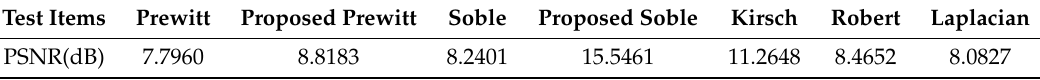
Table 2. PSNR for different